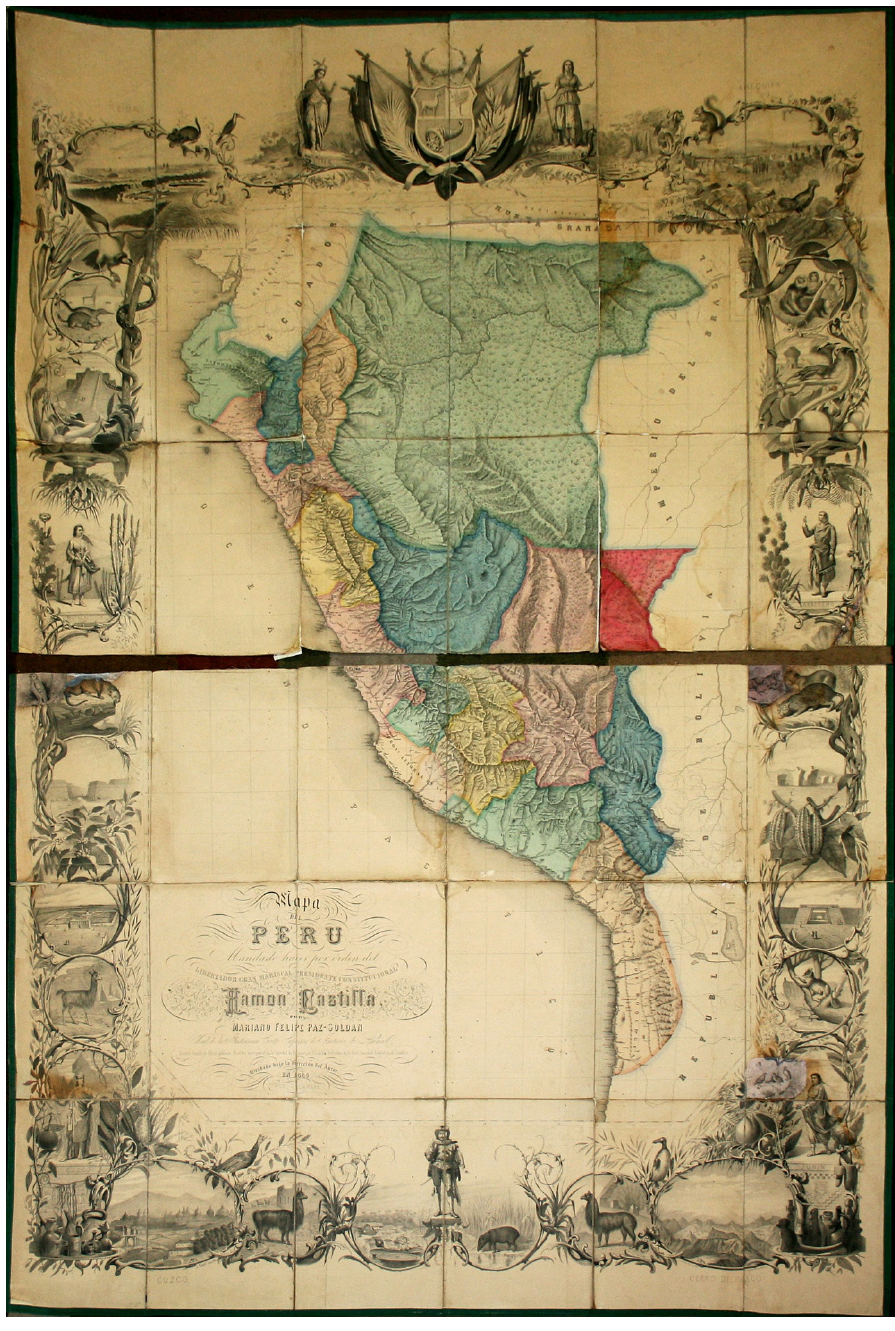
Fig. 4. Map of Peru by Mariano Felipe Paz Soldán (source: Barry Lawrence Ruderman Antique Maps, Inc.